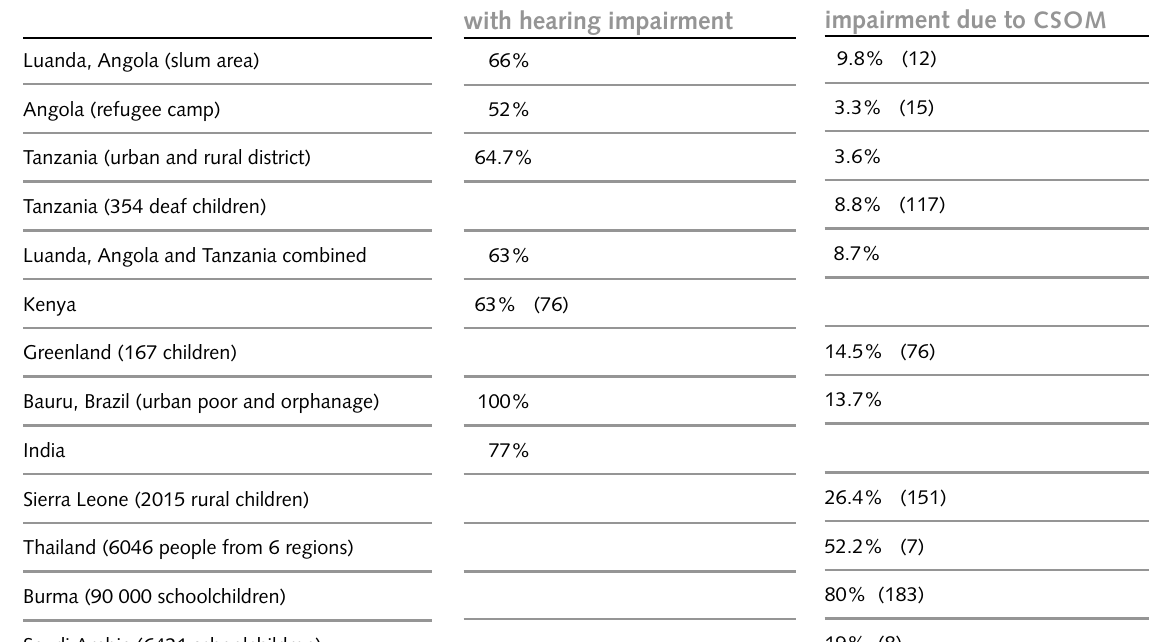
Table 5. Frequency of hearing impairment from CSOM in different study settings